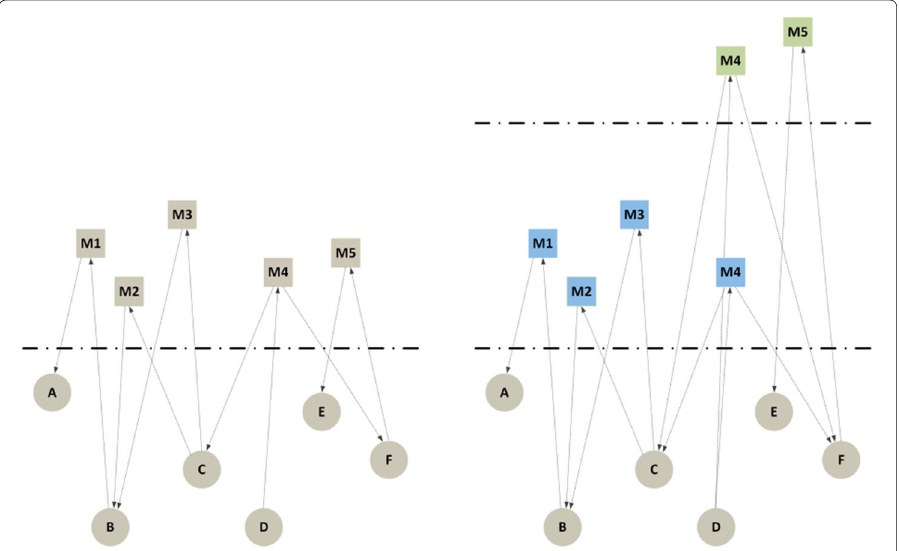
Fig. 9 Textual discretization. ( left ) A temporal text network with 6 actors — circles — and 5 messages — squares; ( right ) the network has been discretized into two clusters — the top one with 2 messages, the bottom one with 4 — based on the topic of the